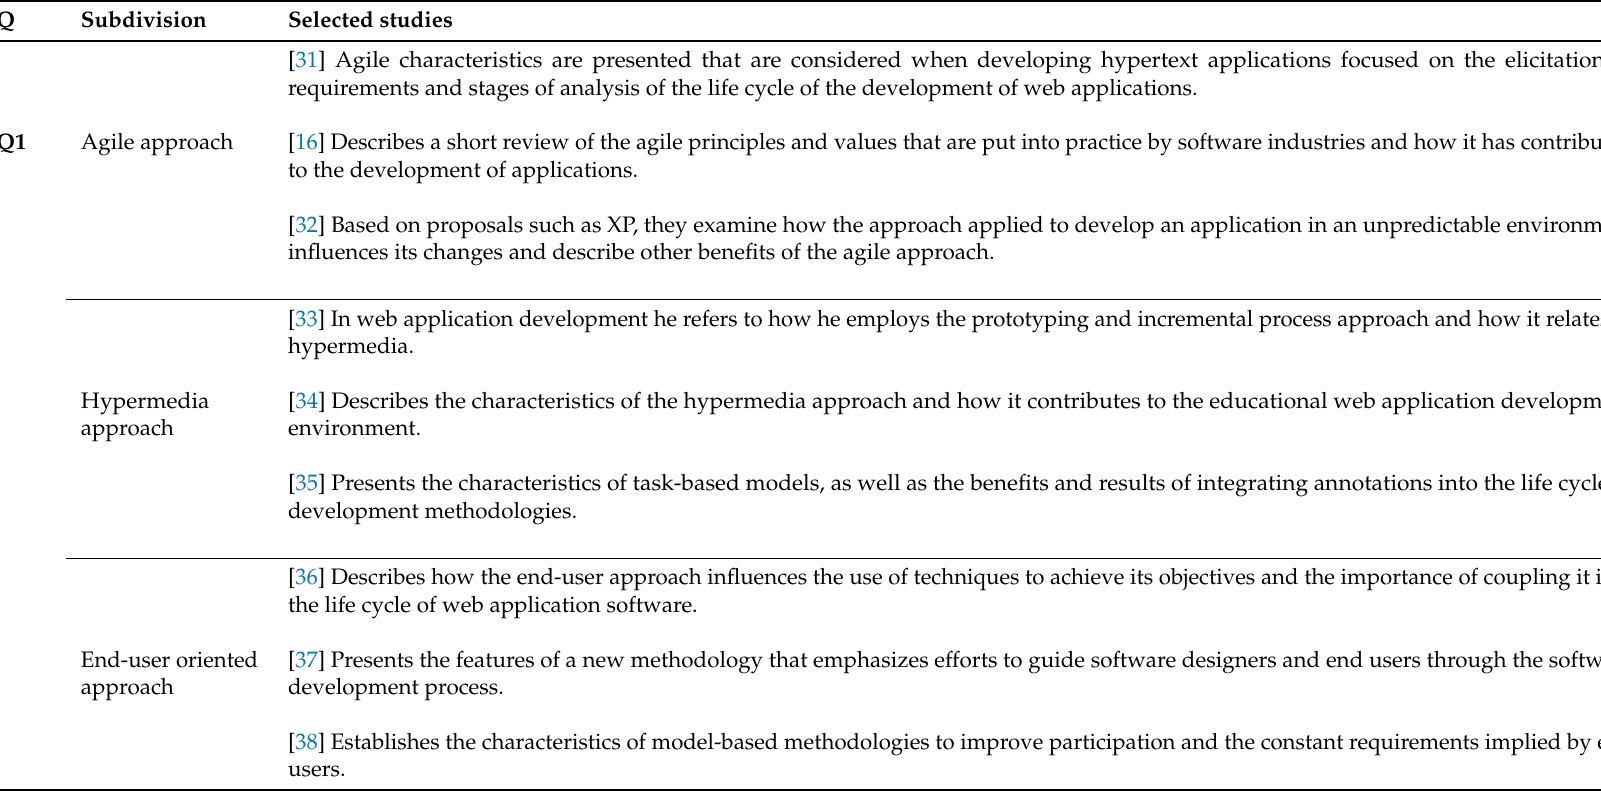
Table 5. Primary studies per